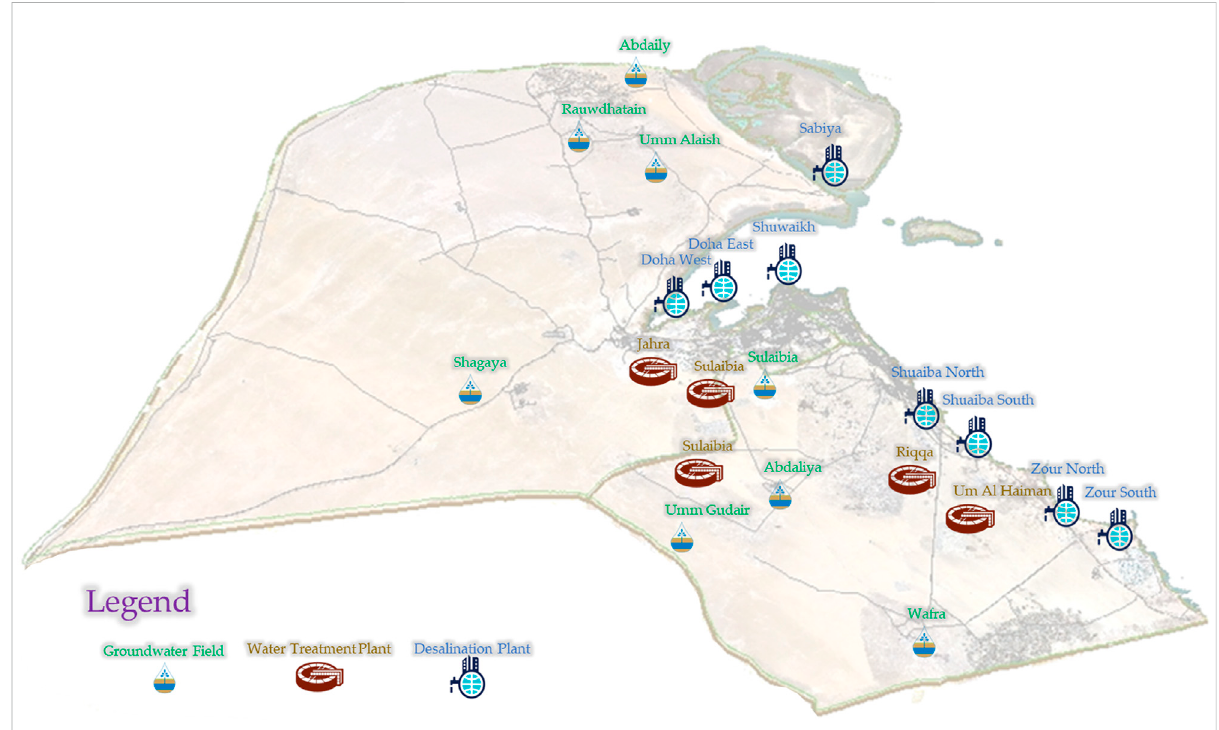
FIGURE 4 Locations of groundwater fi elds, water treatment plants, and desalination plants in